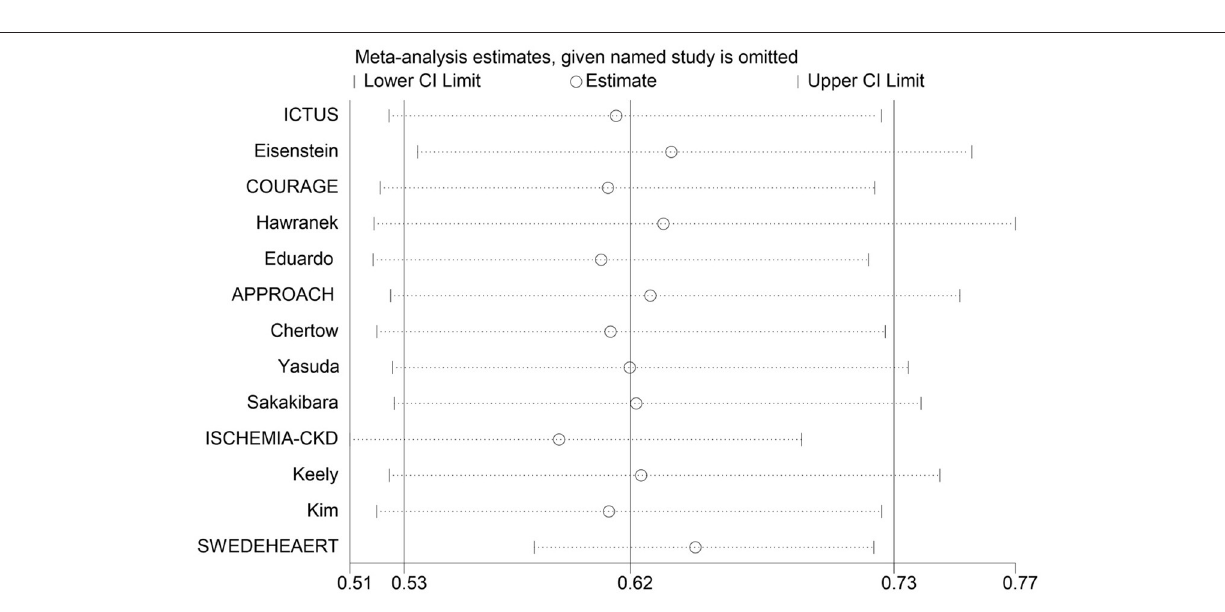
FIGURE 7 | Sensitivity analysis examining the influence of individual studies on relative risk. The sequential exclusion of each study had no obvious effect on the result, indicating the robustness of our